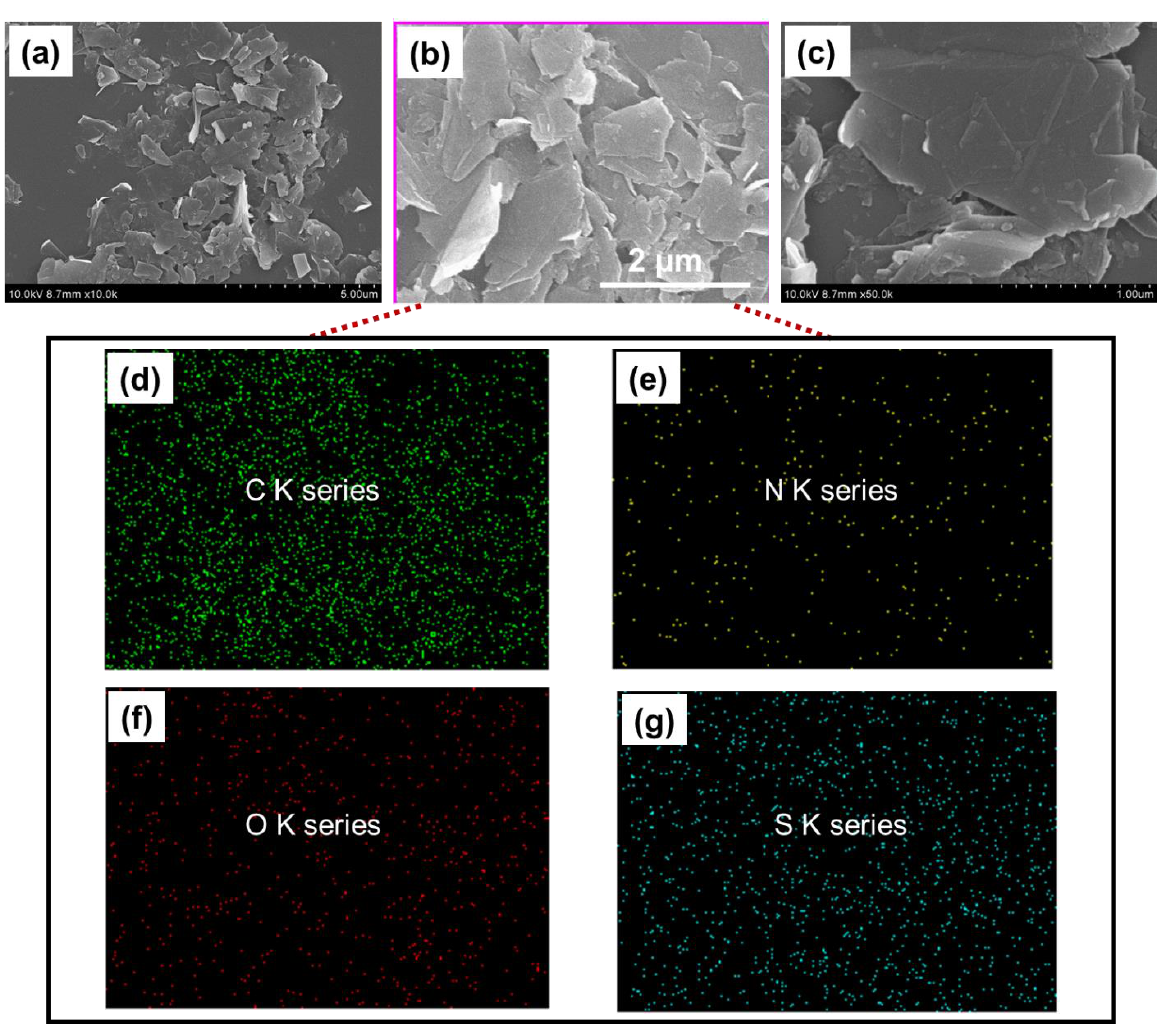
Figure 2. FESEM images of GPSB ( a – c ). Elemental mapping of GPSB C K series ( d ), N K series ( e ), O K series ( f ), and S K series ( g ).